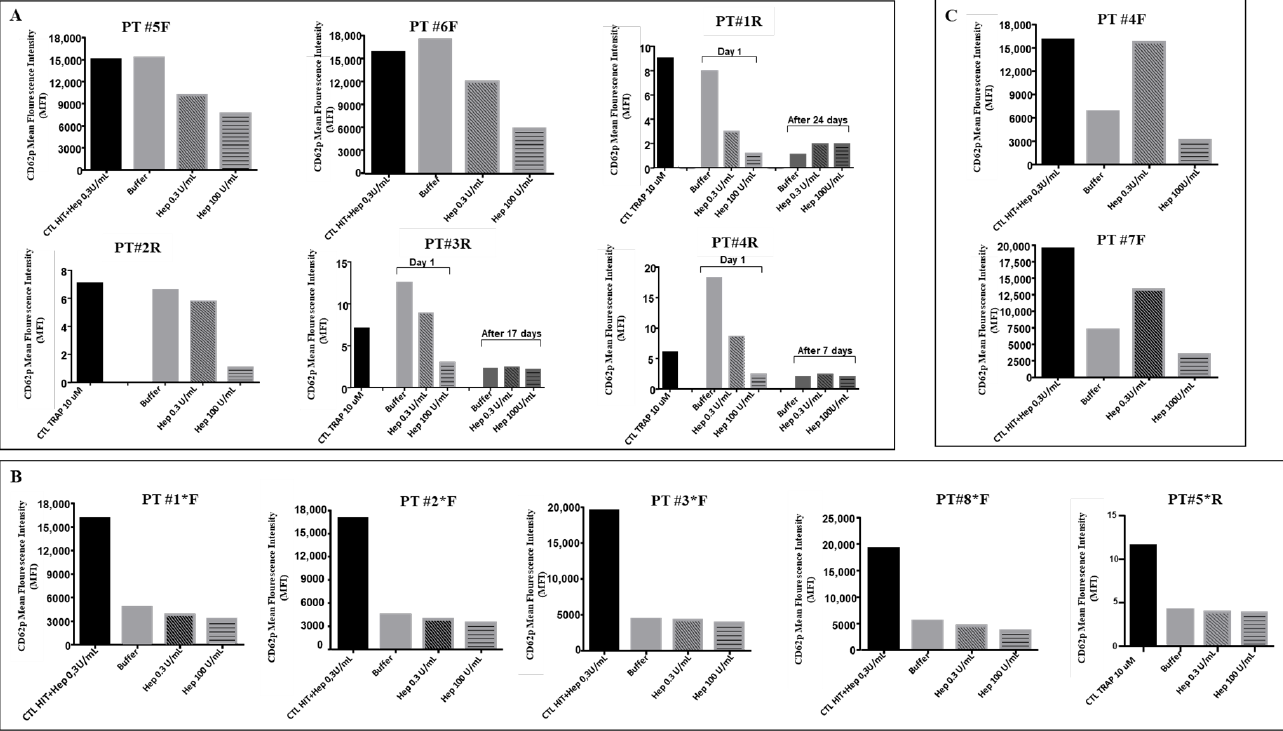
Figure 1. Flow cytometry platelet functional test for identification of anti-PF4/polyanions. P-selectin exposure induced by samples of 13 VITT patients. ( A ) Patients with a typical VITT pattern; ( B ) patients investigated under/after IVIG therapy; ( C ) patients with a HIT pattern. * Patients analyzed under IvIg therapy.